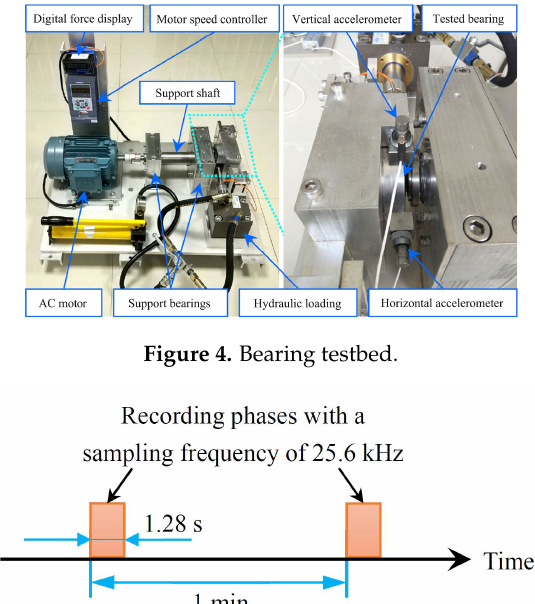
Figure 5. Sampling setting for vibration